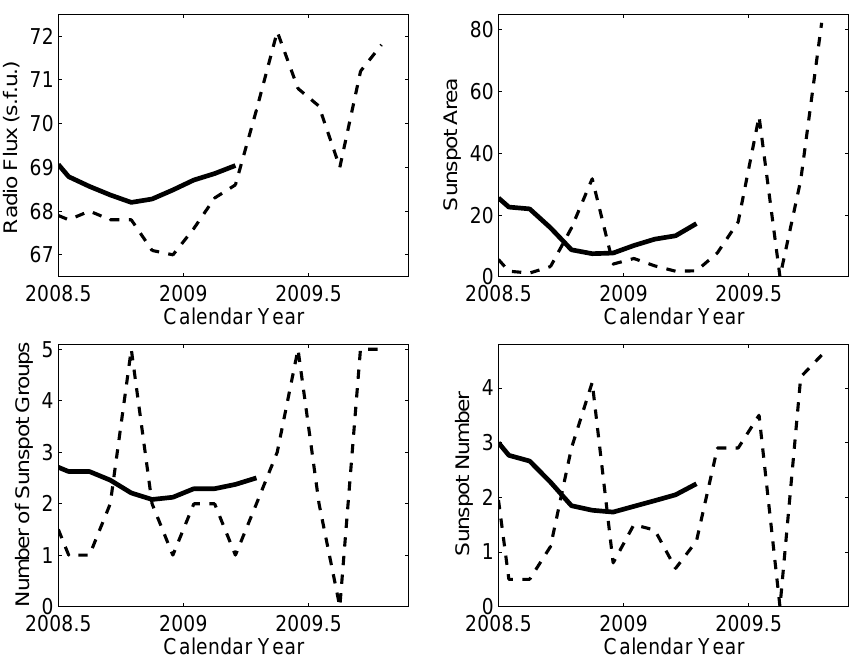
Fig. 4. Top left panel: the monthly mean values of the solar radio adjusted flux density at 10cm wavelength measured by Ottawa/Pentiction (dashed line); top right panel: the monthly mean sunspot areas (dashed line); bottom left panel: the monthly number of sunspot groups (dashed line); and bottom right panel: the monthly mean sunspot numbers (dashed line). All the above data span from January 2008 to September 2009. Their corresponding 13-point smoothed values (solid line) are also shown in their corresponding